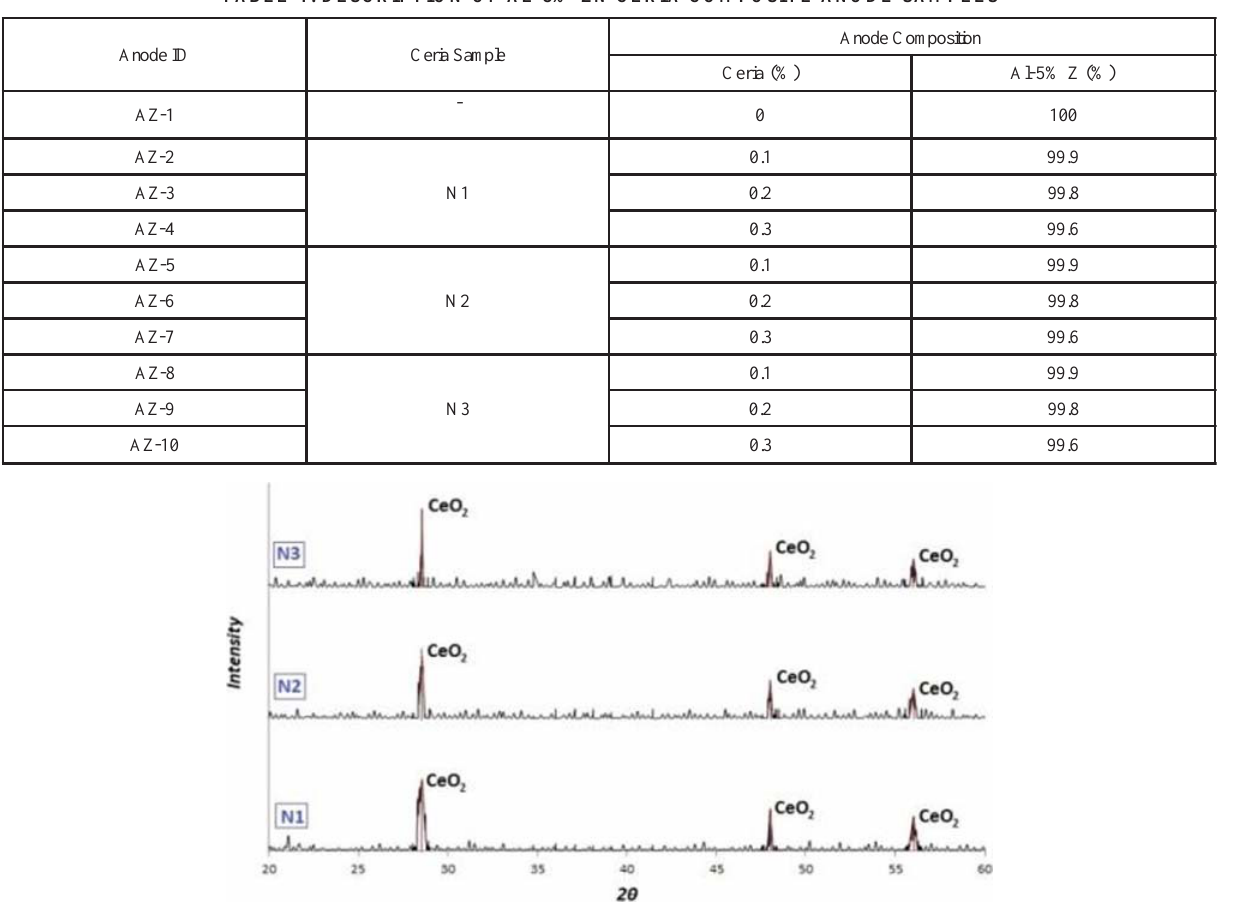
TABLE 1. DESCRIPTION OF AL-5% ZN-CERIA COMPOSITE ANODE SAMPLES